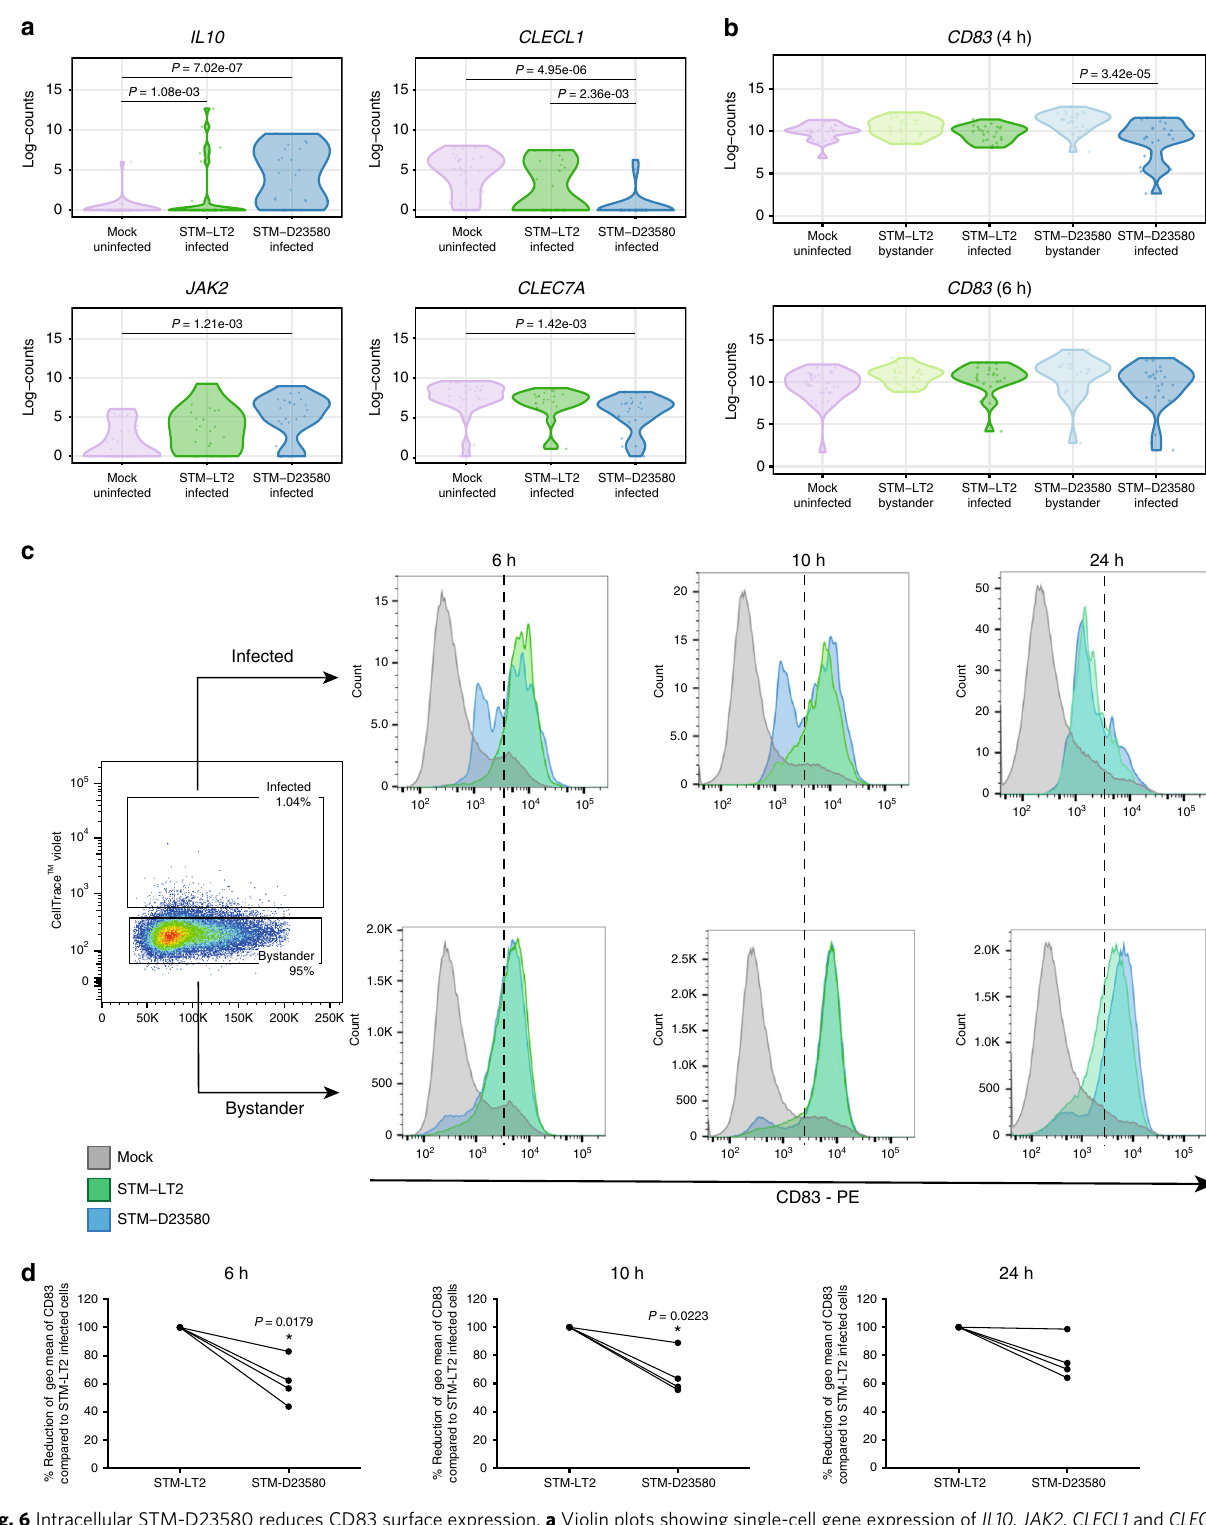
Fig. 6 Intracellular STM-D23580 reduces CD83 surface expression. a Violin plots showing single-cell gene expression of IL10, JAK2, CLECL1 and CLEC7A at 6 h p.i. in infected and uninfected cells. b Violin plots showing single-cell gene expression of CD83 at 4 and 6 h p.i. in all experimental groups. c Flow cytometry histograms showing the expression of surface CD83 on gated infected and bystander cells challenged with STM-D23580 (blue), STM-LT2 (green) or left uninfected (grey) for 6, 10 or 24 h. STM-D23580-infected MoDCs display decreased surface expression of CD83 as compared with STM- LT2. Histograms from one representative example of at least four biological replicates. d STM-D23580 infection reduces surface CD83 levels detected by fl ow cytometry. On the y -axis, the geometric mean of fl uorescence levels for CD83 on STM-D23580-infected cells is represented as a percentage of the level in STM-LT2-infected cells, set at 100%. Four independent experiments are shown. Two-tailed paired Student ’ s t -test, P -value < 0.05